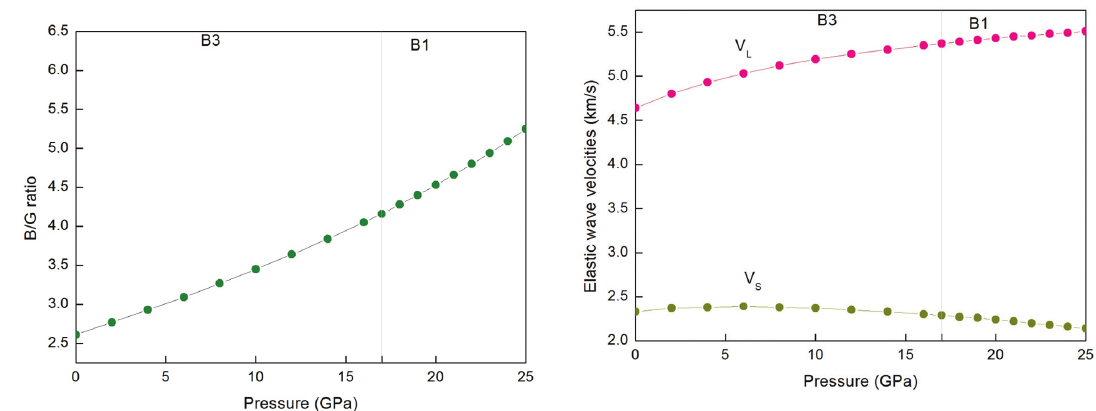
Figure 7. Pressure dependence of elastic wave velocities of ( V and V ) GaAs up to 25 L S